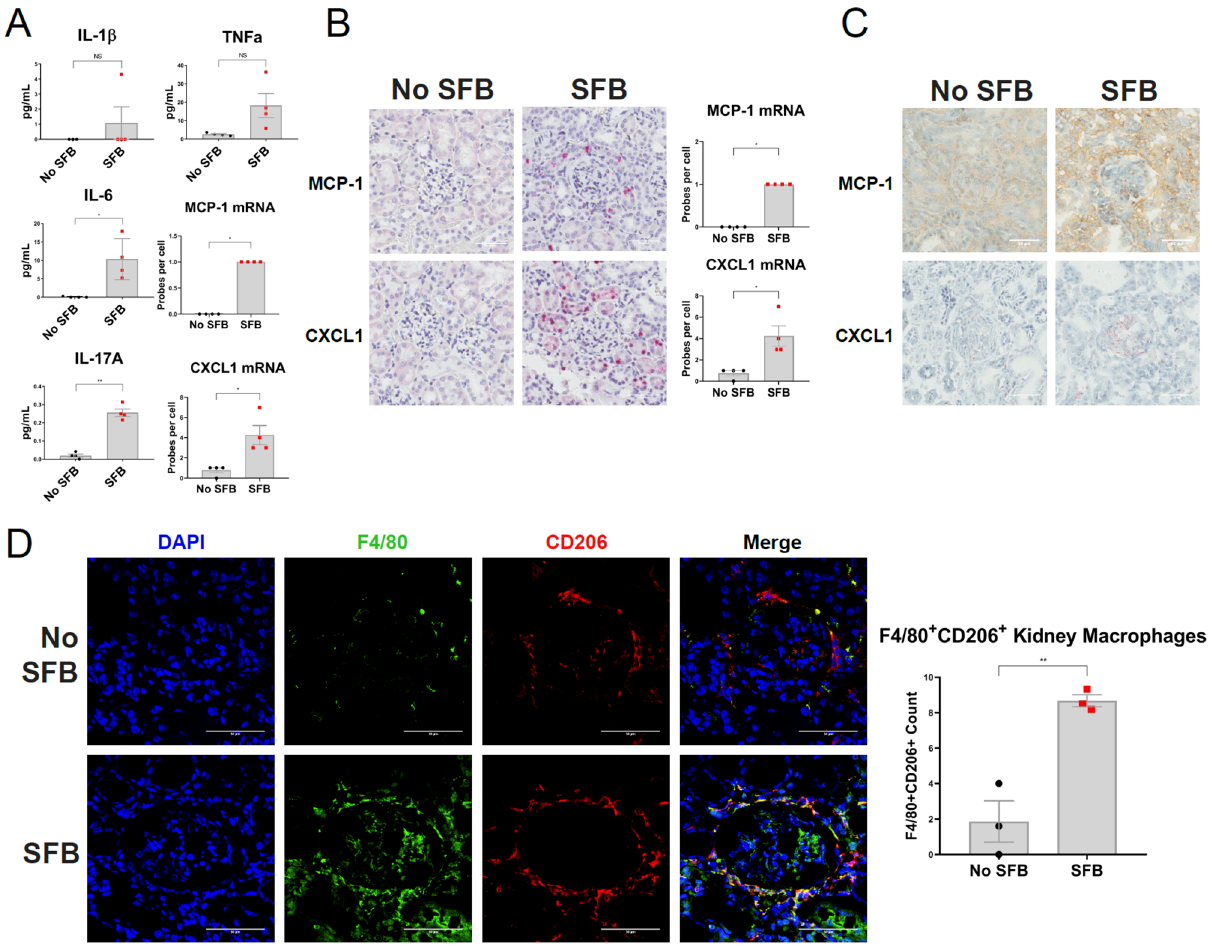
Figure 2. Macrophage chemoattractants and M2-like macrophages are elevated in the kidneys of NZM2410 mice colonized with SFB. ( A ) Proinflammatory serum cytokines and chemokines as measured by ELISA at 30 weeks of age. ( B ) mRNA levels of MCP-1 and CXCL1 in kidney tissue as measured by RNAScope. ( C ) IHC staining for MCP-1 (DAB staining) and CXCL1 (AEC staining) proteins in kidney tissue. ( D ) Immunofluorescence staining of kidney tissue for F4/80 (green), CD206 (red) and nuclei (blue). Error bars represent mean ± SEM ( A , B , D ). Unpaired Student t test ( A , B , D ). NS, not significant; * p < 0.05; ** p < NZM2410 mice with worse kidney disease had expanded Th17 cell and ILC3s than −SFB mice. Serum IL- 17A was increased in 30-week old SFB-colonized mice when compared to controls (Fig. 2A). However, kidney